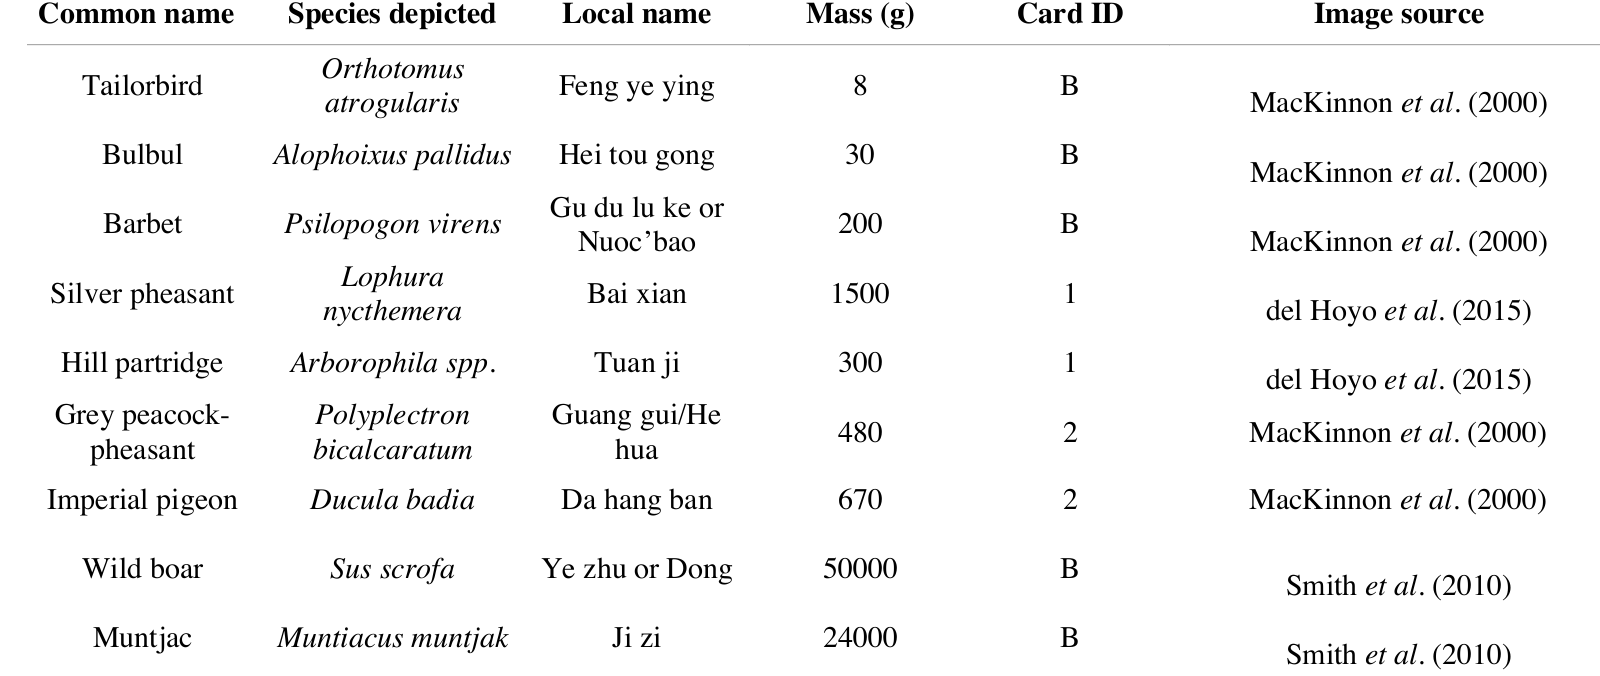
Table A4: The set of animals that the respondents ranked. Field guide images of each taxon were printed onto laminated card-stock (11” x 14”). There were two cards: A and B that the enumerators switched between using a coin toss. Common name denotes the species or genus of interest. For cases where a genus was the example (e.g. tailorbird), a representative species was chosen to include on the card. Card ID indicates if the taxon was shown on both (B), the first (1), or second (2) cards. 16 respondents ranked the first card (A) and 11 ranked the second (B).